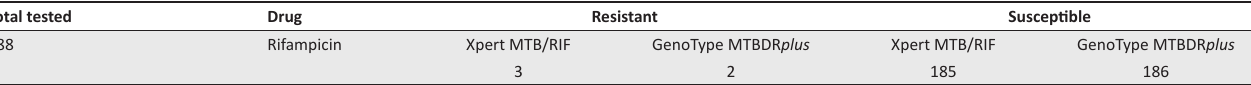
TABLE 3: Rifampicin susceptibility results ( n =188) from both GenoType MTBDR plus and Xpert MTB/RIF for outpatients at Bwaila Hospital, Lilongwe, Malawi (2011–2012). Total